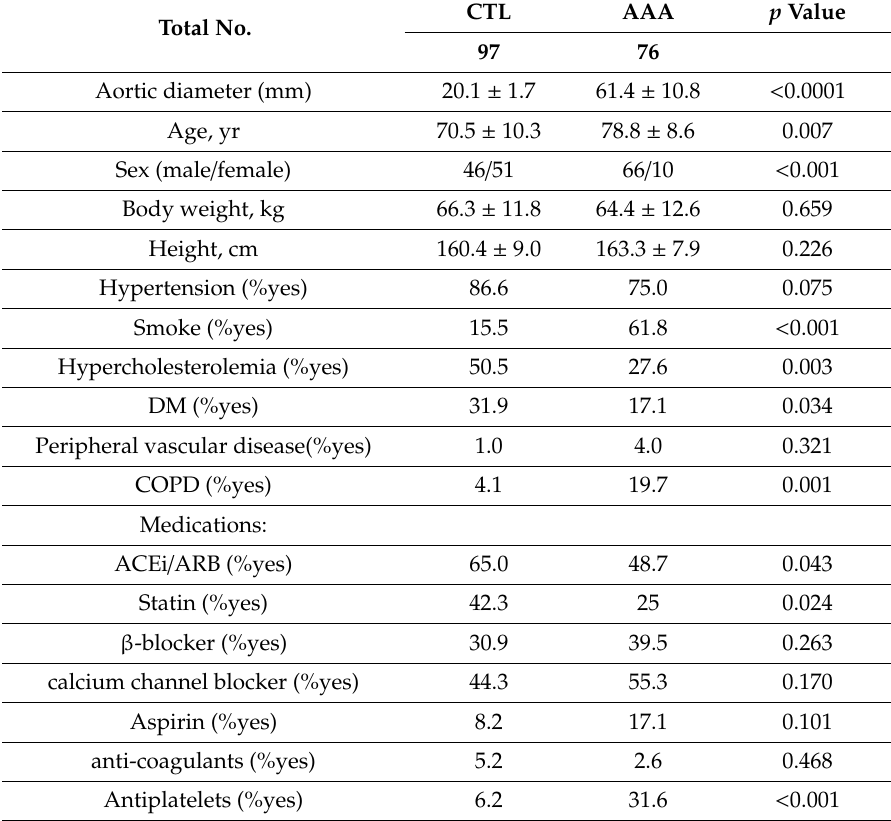
Table 1. Demographic characteristics of control subjects and AAA patients. Total No.